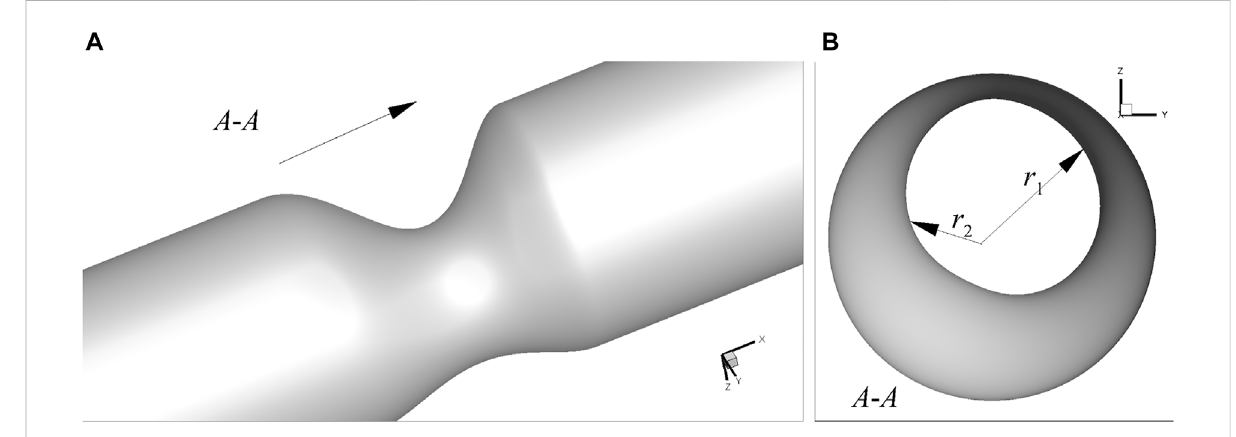
FIGURE 13 An example of 3D asymmetric stenosed artery: (A) 3D view, and (B) x -axis view.